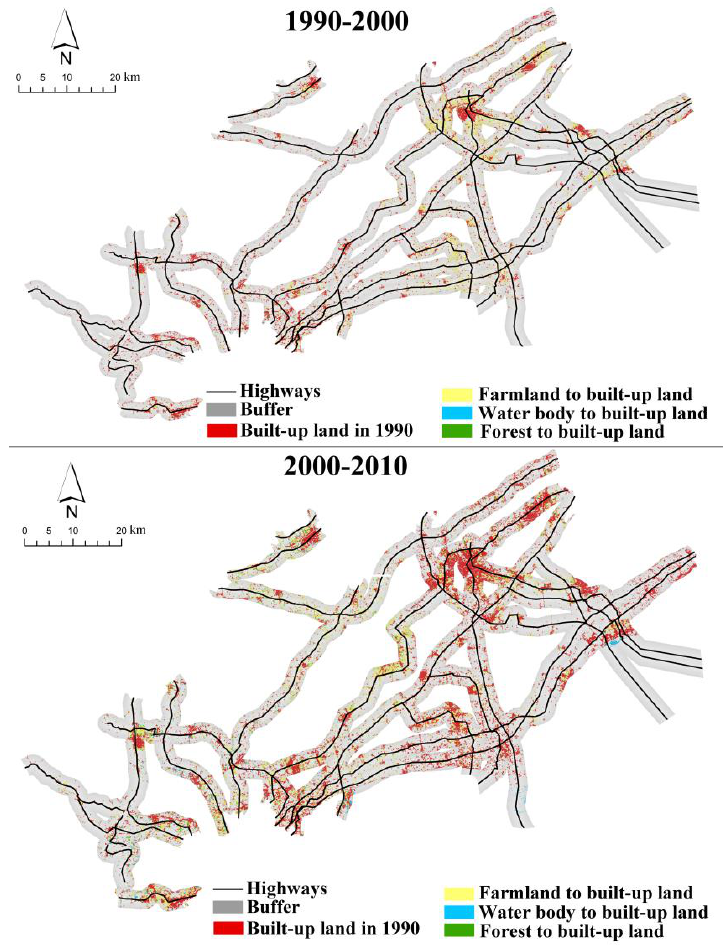
Figure 6. Spatial distribution of built-up land expansion and the major components of land-use changes in the highway-effect zone ( a ) 1990–2000; ( b ) 2000–2010.